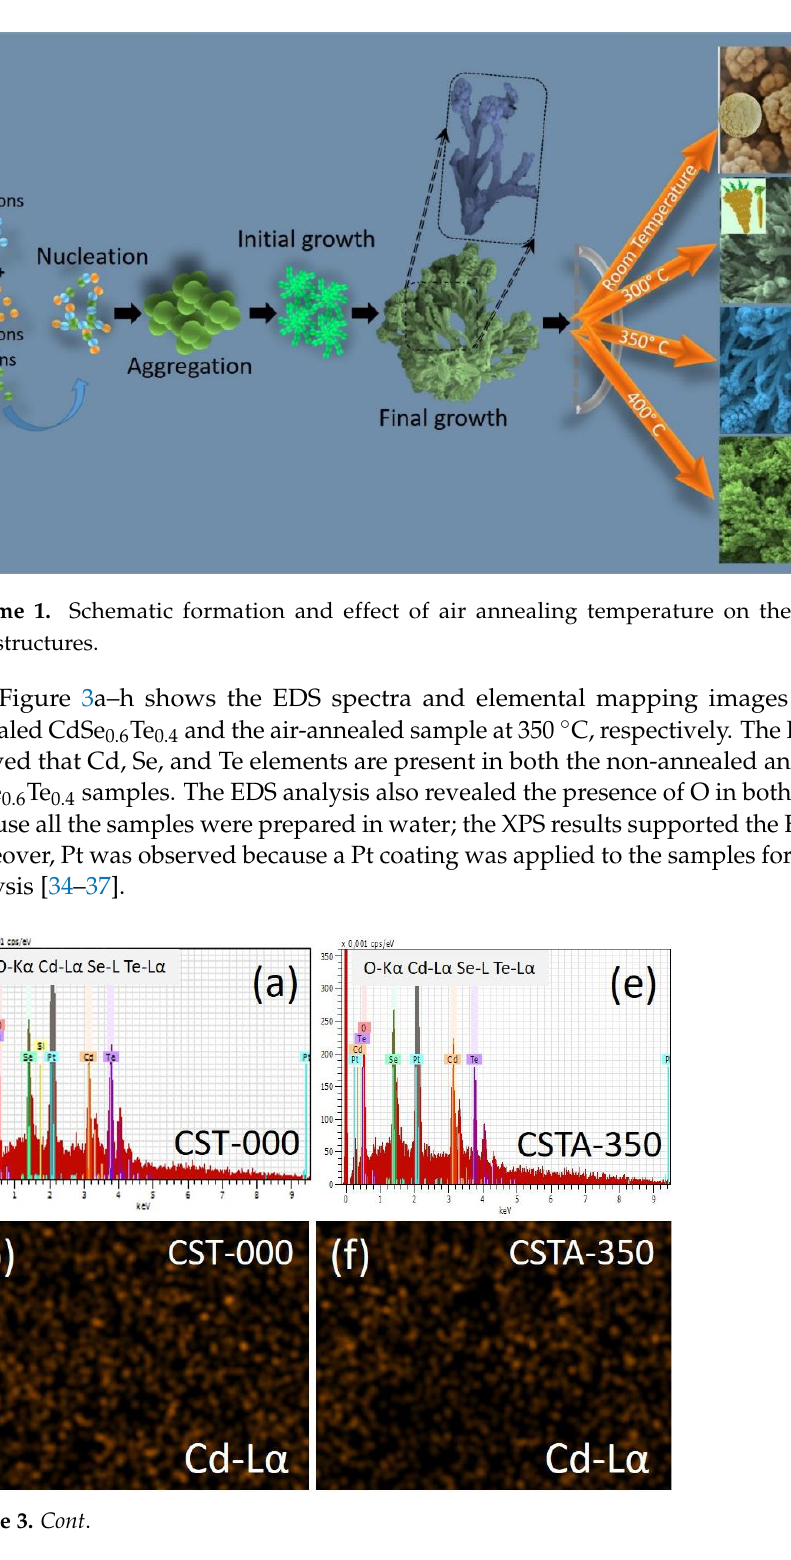
Figure 3. ( a – h ) EDS and elemental mapping of non-annealed and optimized annealing temperature at 350 ° C of CdSe 0.6 Te 0.4 , respectively. 2.5. Band Gap Energy Study Figure 4 shows the optical band gap energy plots of the non-annealed CdSe 0.6 Te 0.4 samples and the annealed ones at 300, 350, and 400 °C. The optical band gap energy was obtained using the following Equation (1) [35]: /2 g ( ) n A h E h    − = (1) where A and n are constants, “ hν ” is the photon energy, and E g is the band gap energy. The direct and indirect band gap energies of semiconductor materials depend on the aforementioned values. The band gap energy results indicate that the non-annealed and annealed CdSe 0.6 Te 0.4 samples are semiconductor materials with direct band gap energies.